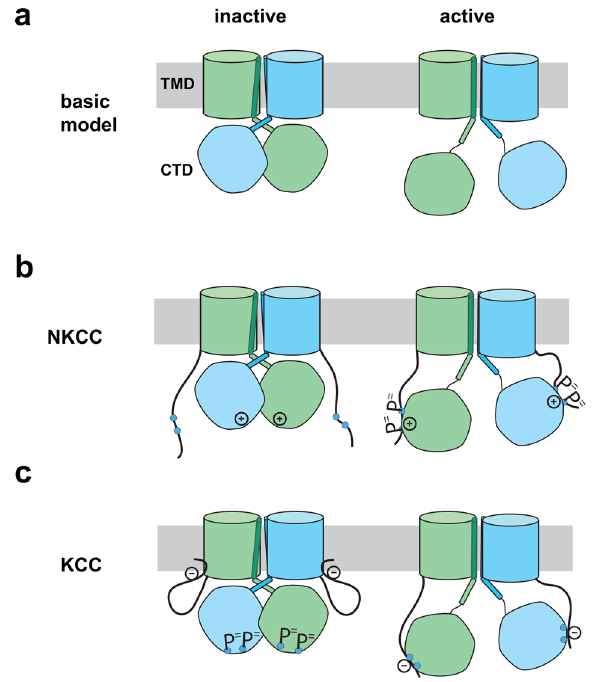
Fig. 7 Hypotheses of regulatory activation in CCCs. a The basic model of cation-chloride cotransporter activation. It is proposed that the inactive state is characterized by an inward-open TM conformation with CTDs in a tightly organized domain-swap con fi guration. On activation, the CTDs are released to a freely tethered con fi guration with accompanying change in the dimer architecture. b Our hypothesis is that NKCC activation occurs when the phosphorylated N terminus interacts with the CTD and disrupts the dimer. c The KCC inactive state exhibits an N terminus inhibitory peptide blocking the transport pore. Activation occurs when the peptide instead binds to the non-phosphorylated C